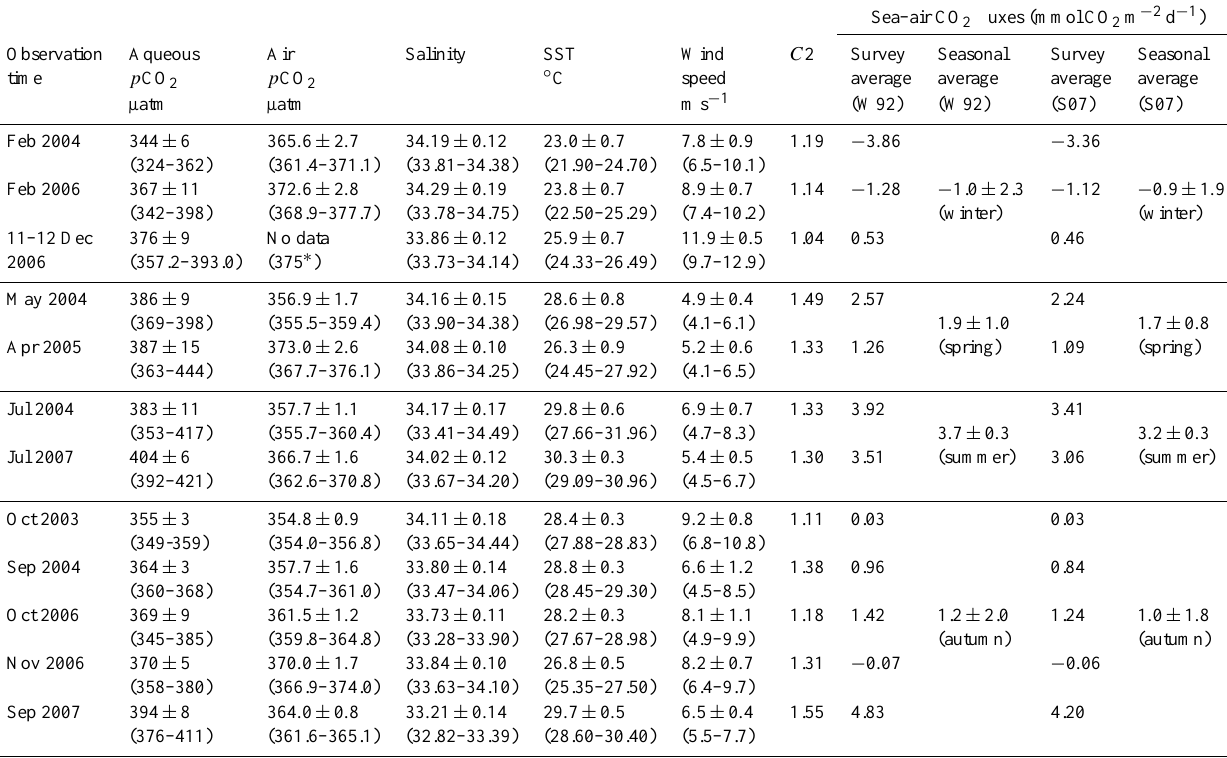
Table 4. Summary of p CO 2 , salinity and SST along cruise tracks, monthly satellite-derived wind speed, and sea–air CO 2 flux estimation in